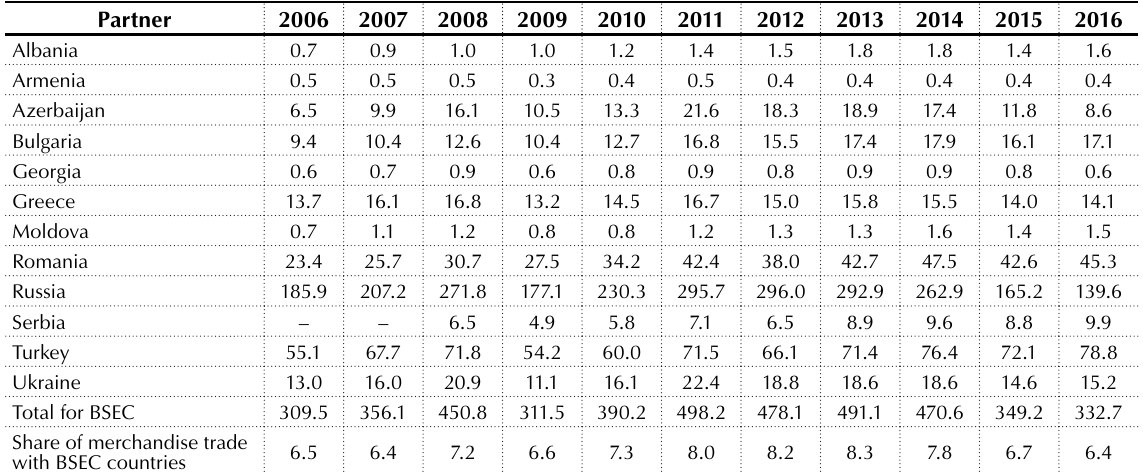
Source: UNCTAD and authors’ calculations.